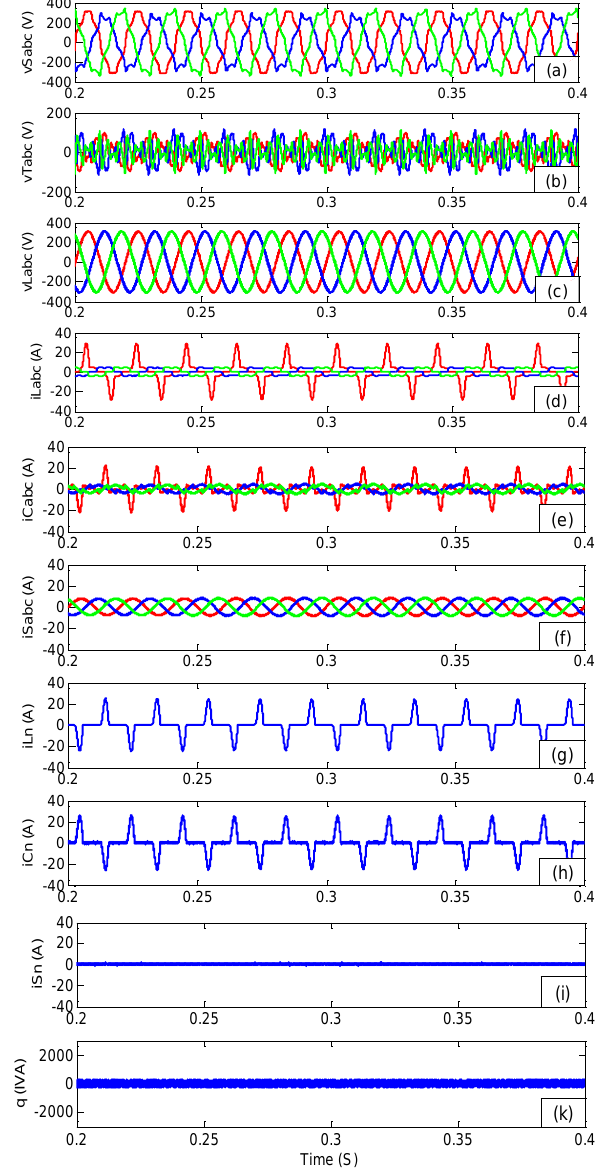
Figure 5. Simulation results for the proposed control approach for: (a) source distortional voltages, (b) voltages injected by transformer (c) load voltages (d) unbalanced and nonlinear load currents (e) currents injected by compensator (f) source currents (g) load neutral current (i) neutral current injected by compensator (h) instantaneous reactive